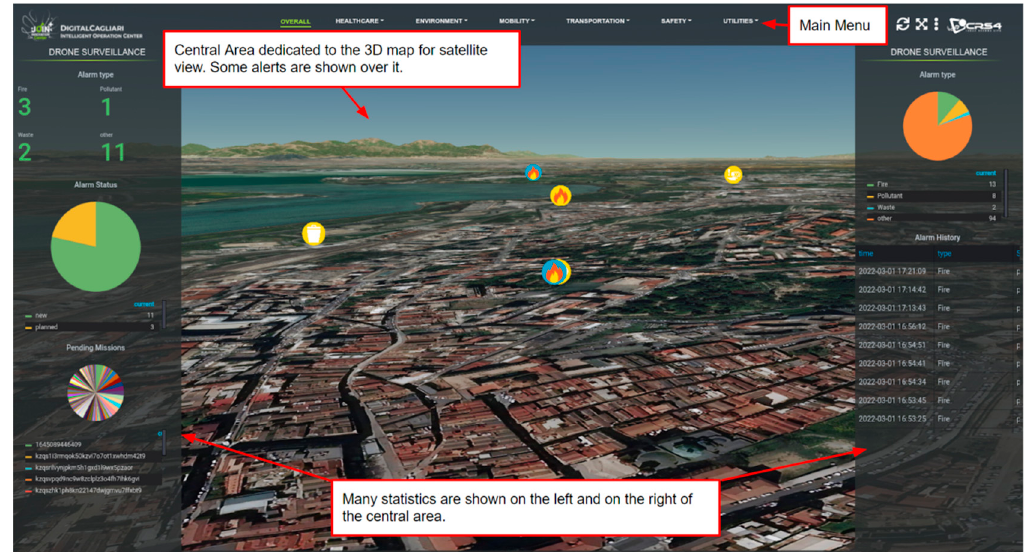
Figure 4. The Smart City platform, with some alerts related to fire ignition and illegal dumping .